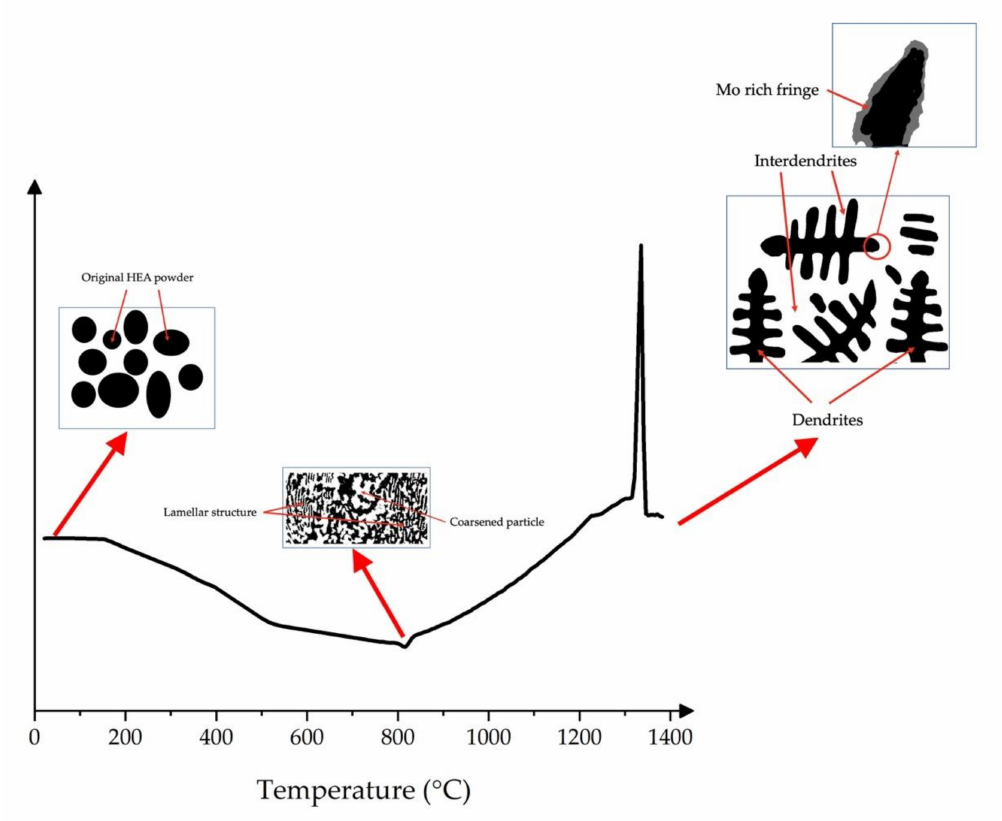
Figure 6. Schematic of the phase evolution within this HEA consisting of the initial powder status, transition state and final microstructure solidified from